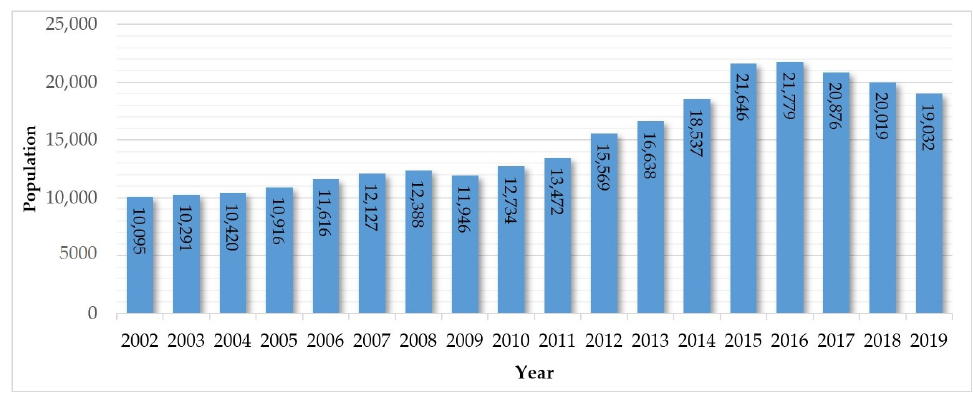
Figure 7. ESPOL historical population registry [53].